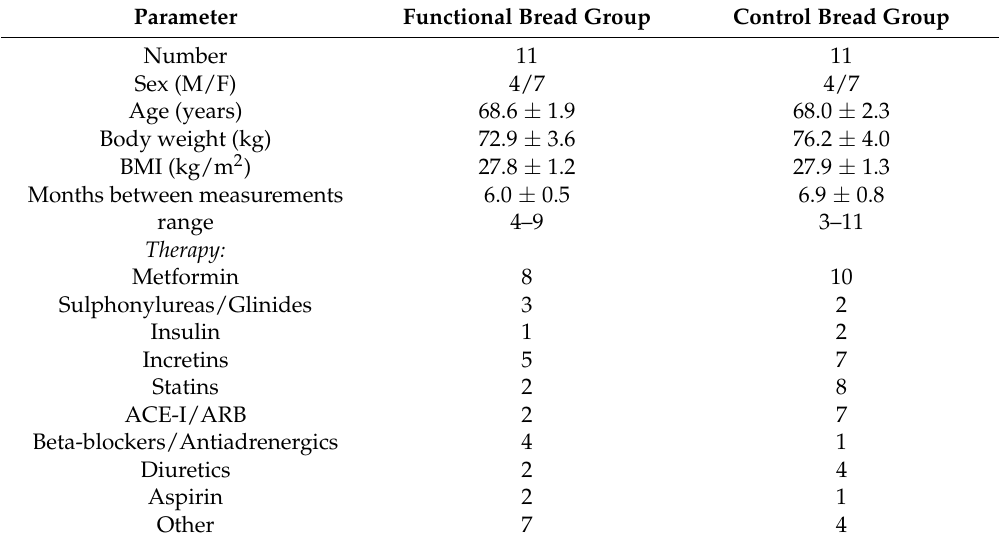
Table 2. Clinical characteristics of the type 2 diabetic subjects, included in either the functional bread or the control group. Data are expressed as means ± SE. Functional Bread Group Control Bread